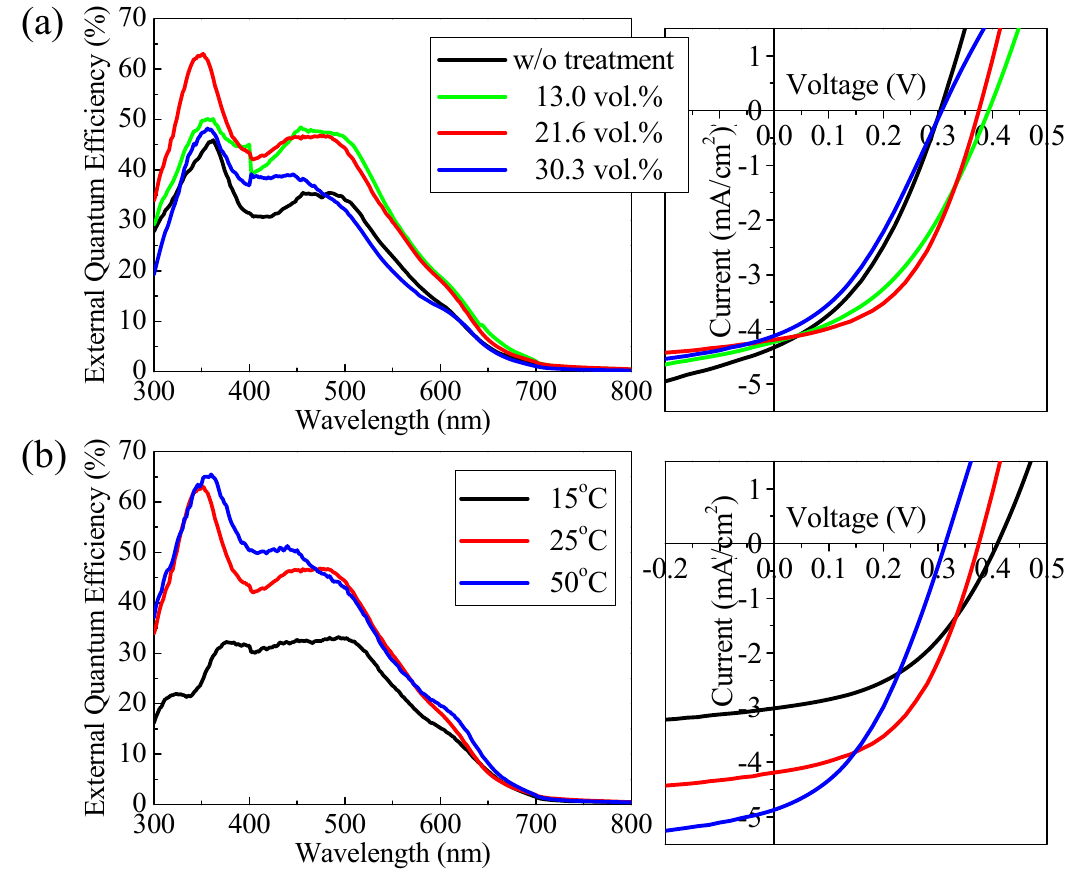
Figure 7. External quantum efficiency (EQE) spectra and current-voltage characteristics under AM1.5 (100 mW/cm 2 ) solar-illuminated conditions in ITO/C interpenetrating heterojunction solar cells depending on ( a ) vapor concentration at a temperature of 25 °C, and ( b ) temperature at 21.6 vol % vapor concentration in the SVT.